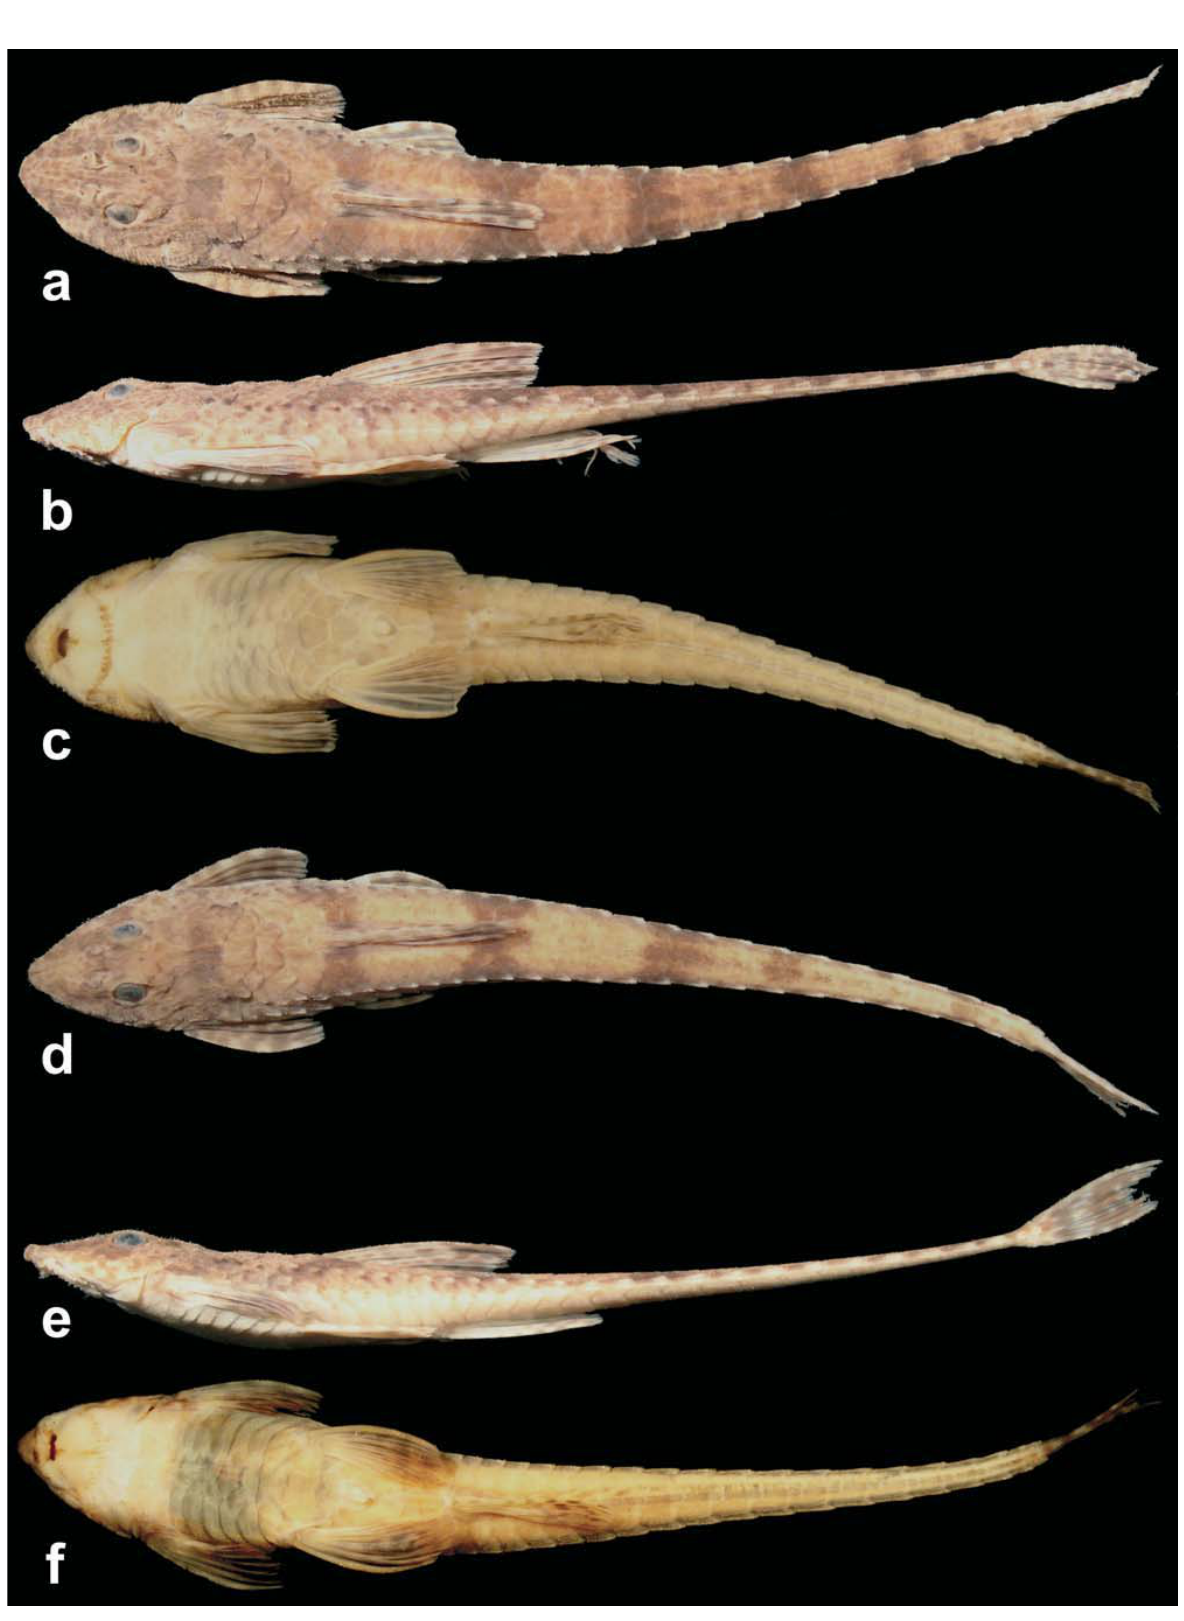
Fig. 1. Rineloricaria langei . a-c : holotype, male, MCP 42506, 114.9 mm SL; d-f : paratype, female, MCP 23459, 89.2 mm SL, rio Iraí, Quatro Barras, Paraná,